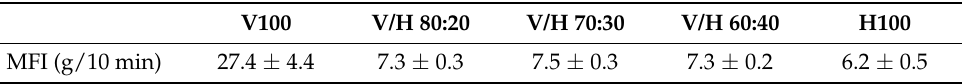
Melt-flow index (MFI) of poly(3-hydroxybutyrate- co -3-valerate) (PHBV), poly(3- hydroxybutyrate- co -3-hydroxyhexanoate) (PHBH), and their blends at 180 ◦ C and 2.16 kg of load. V100